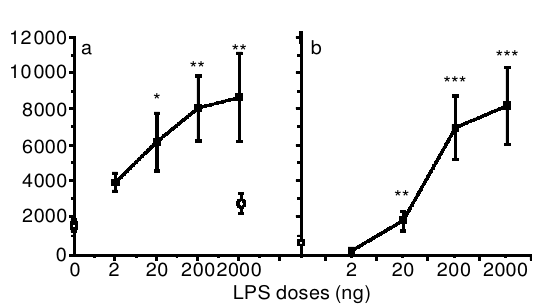
FIG. 1. Dose-dependent leukocyte and neutrophil recruit- ment induced by LPS ( j ) but not by compound 48 / 80 ( s ) into rat air pouches. LPS, at the doses of 2, 20, 200, 2000 ng was injected under a volume of 1 ml and samples removed at 2 h. Compound 48 / 80 at the dose of 250 m g and PBS was tested under the same volume and at the same time-point. Responses are for (a) leukocyte and (b) neutrophil recruit- ment and are expressed as mean SEM of total number of cells per pouch for leukocytes ( n = 5 ± 7) and neutrophils ( n = 5 ± 7) in LPS-treated animals ( j ) and in PBS-treated animals ( h ) ( P , 0.05, P , 0.01, P ,